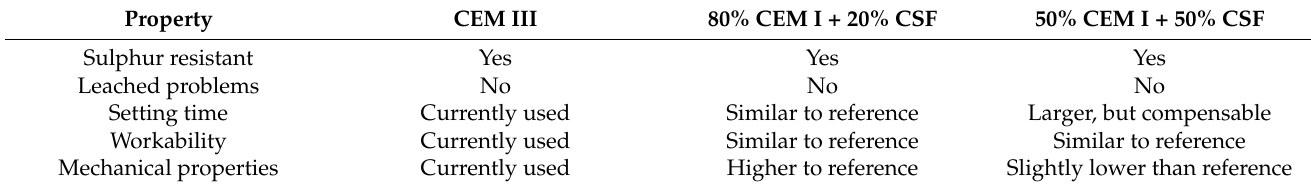
Table 7. Comparison of the properties of the different cements and